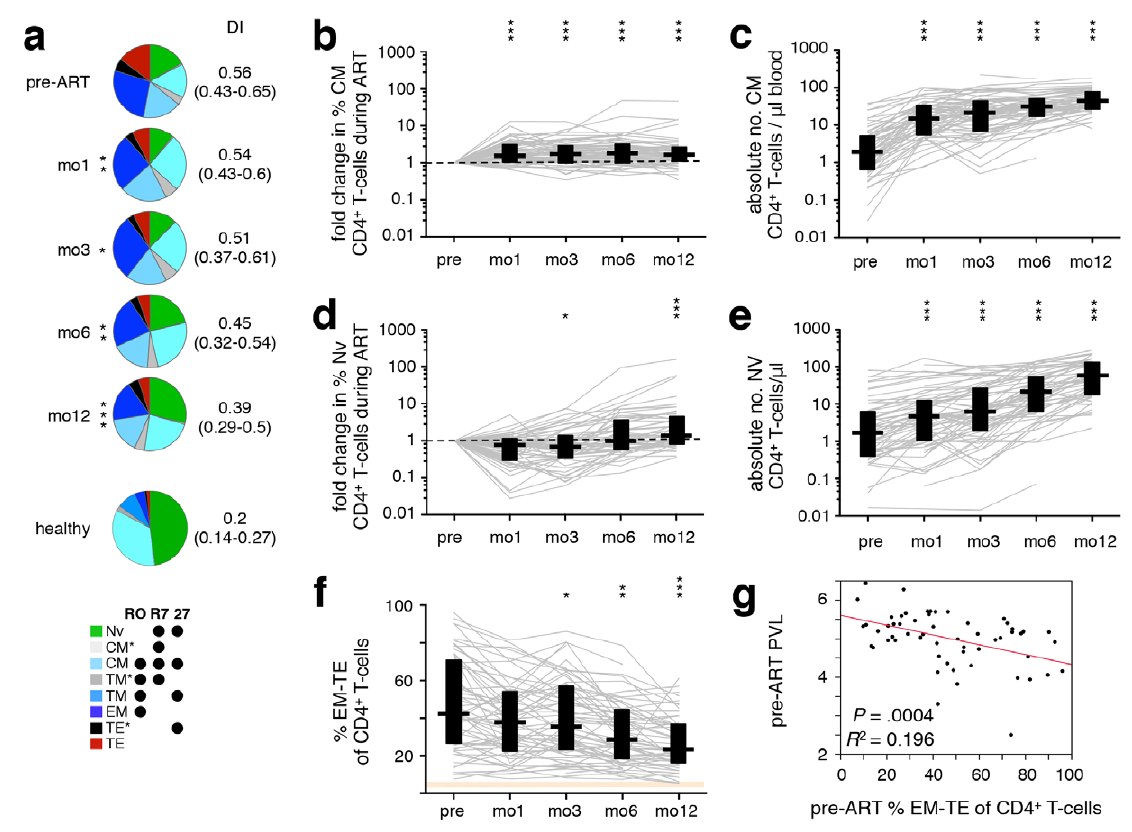
Figure 2. ART-induced change towards less differentiated CD4 + T cells. PBMC were sampled before ART, and after 1, 3, 6, and 12 months of ART. (A) The differentiation pattern was investigated in CD4 + T cells. Subsets were defined by expression of CD45RO (“RO”), CCR7 (“R7”) and CD27 (“27”). T –naïve; NV T –central memory; T –transitional memory; T –effector memory; T –terminal effector. T , T , CM TM EM TE CM* TM* and T are populations not classically discussed in the literature, but arise by this gating scheme; their TE* activation phenotype and cytokine potential most closely resemble that of T , T , and T , respectively, CM TM TE hence their nomenclature. Differentiation indices (DI; medians and interquartile ranges) are indicated. The change in frequency over the course of treatment relative to pre-ART levels (B, D), as well as absolute cell count (C, E) of T (B, C) and T (D, E), and total frequency of late-differentiation (T , T , and T ) NV CM EM TE* TE (F) CD4 + T-cells are shown. (G) Pre-ART PVL was plotted against pre-ART late-differentiation (T , T , EM TE* and T ) CD4 + T cells. Graphs show development in individual patients, as well as medians and interquar- TE tile ranges. Corresponding interquartile ranges in healthy donors are shown where applicable (orange). All time-points were compared to corresponding pre-ART measurements: * P < 0.01, ** P < 0 .001, *** P < 0